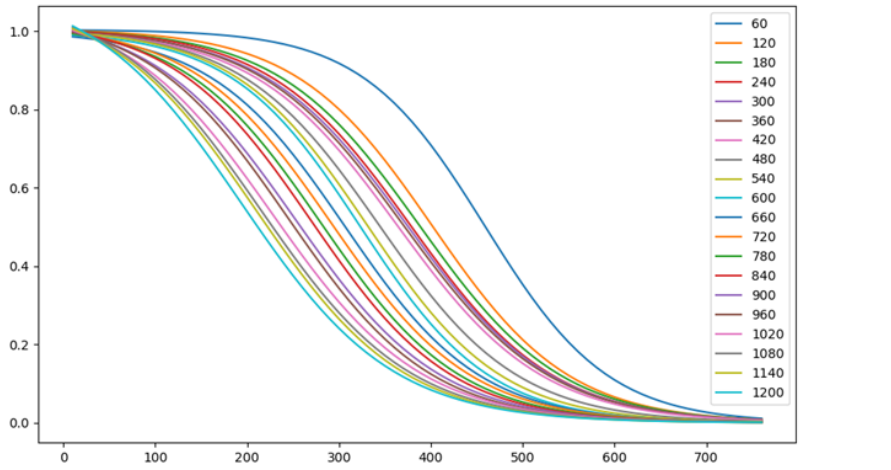
Figure 2. PRR of C-V2X communication fitted the data in the previous